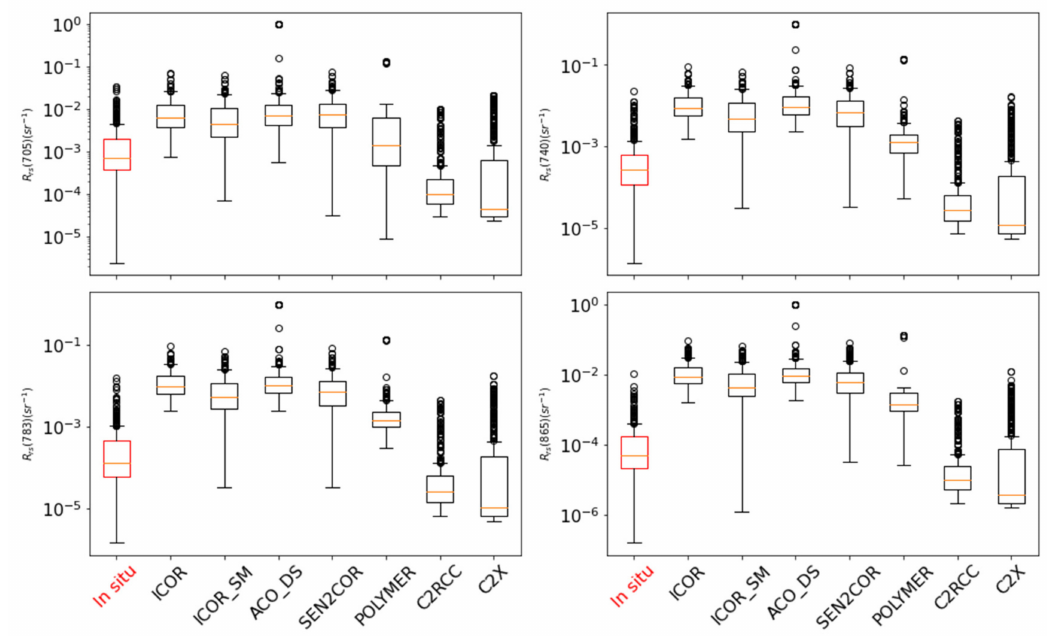
Figure 11. Comparison of the distributions of the in situ measured R rs and R rs retrieved by each processor in the NIR bands (705 nm, 740 nm, 783 nm, and 865 nm) for S2/MSI. The median values are shown as the green lines, and the circles represent the